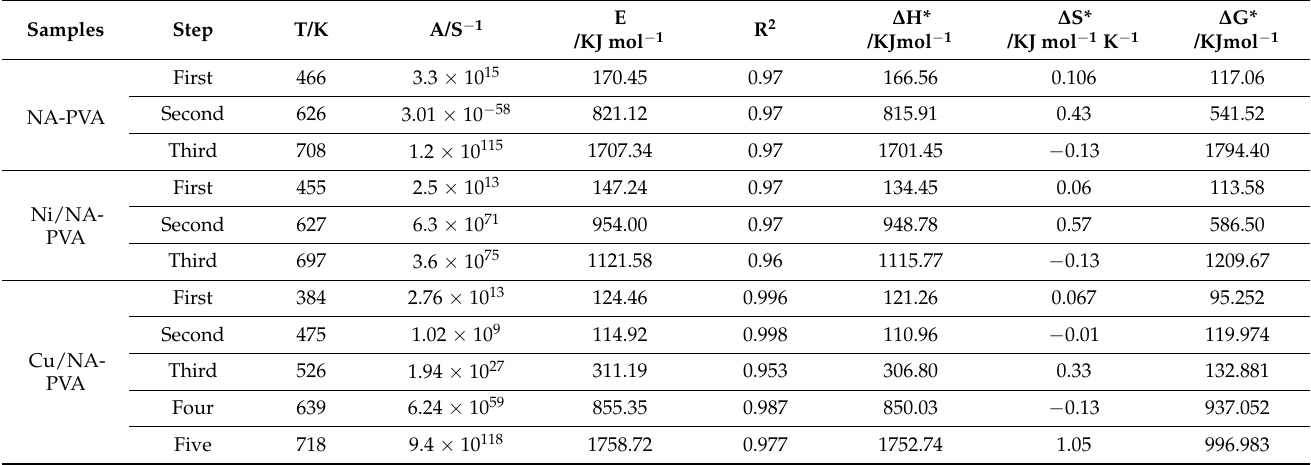
Table 1. The Kinetic Parameters of NA-PVA, Ni II and Cu/NA-PVA by Coats Redfern program. Samples